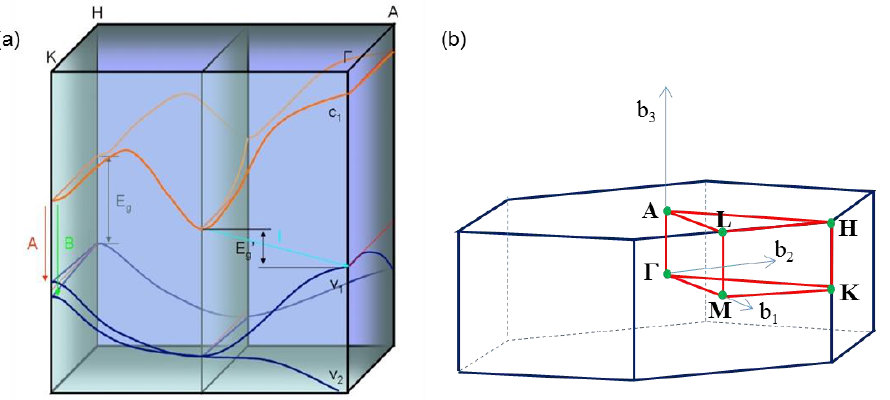
Figure 4. ( a ) Simplified electronic band structure of bulk MoS 2 [46]. Reprinted figure with permission from [Mak, K.F.; Lee, C.; James, H.; Jie, S.; Heinz, T.F. Atomically Thin MoS 2 : A New Direct-Gap Semiconductor . Phys. Rev. Lett. 2010 , Phys. Rev. Lett. 105.136805] Copyright (2010) by the American Physical Society. ( b ) Brillouin zone and special point of the hexagonal lattice system (MoS 2 )